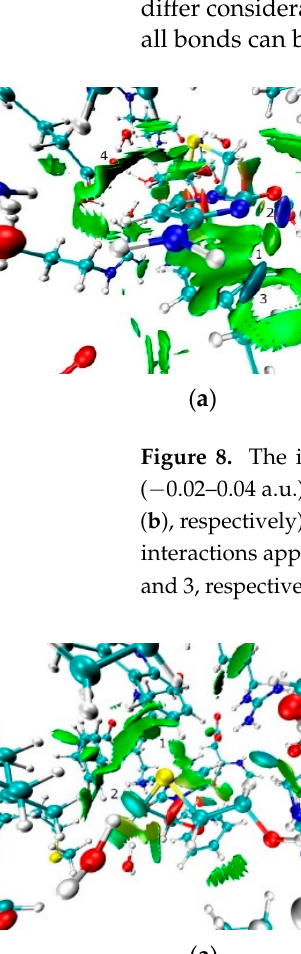
Figure 9. The isosurfaces of RDG function (0.35 a.u.) colored according to the λ 2 eigenvector ( − 0.02– 0.04 a.u.) in the region of the 3-thiacytidine moiety of complexes A and B ( a and b , respectively). The negative values are blue-colored, while positive ones are red-colored. The C-H…S interactions are depicted at point 1, while the O-H…S interaction ( a ) and intramolecular O-H…O bond ( b ) are depicted at point 2. Near point 3, a strong O-H…O bond with COO- moiety of an amino acid ( a ) or N-H…O bond ( b ) is observed.